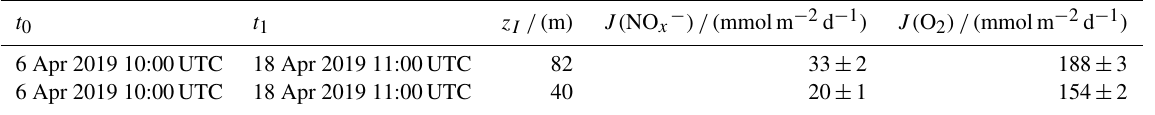
Table 1. Summary of NO x − inventory changes. Inventories are calculated using either a depth consistent with the mean euphotic depth ( z I = 40m) or the full water column ( z I = 82m). J( NO x − ) is net community production in NO x − equivalents. J( O 2 ) is net community production in O 2 equivalents.